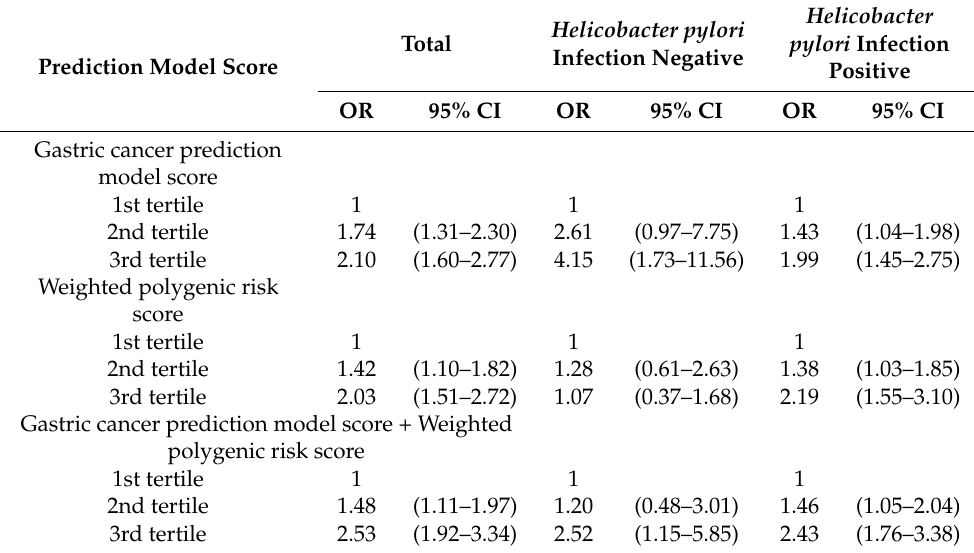
Table 3. Association of tertiles of the gastric cancer prediction model score and polygenic risk score according to Helicobacter pylori infection status.